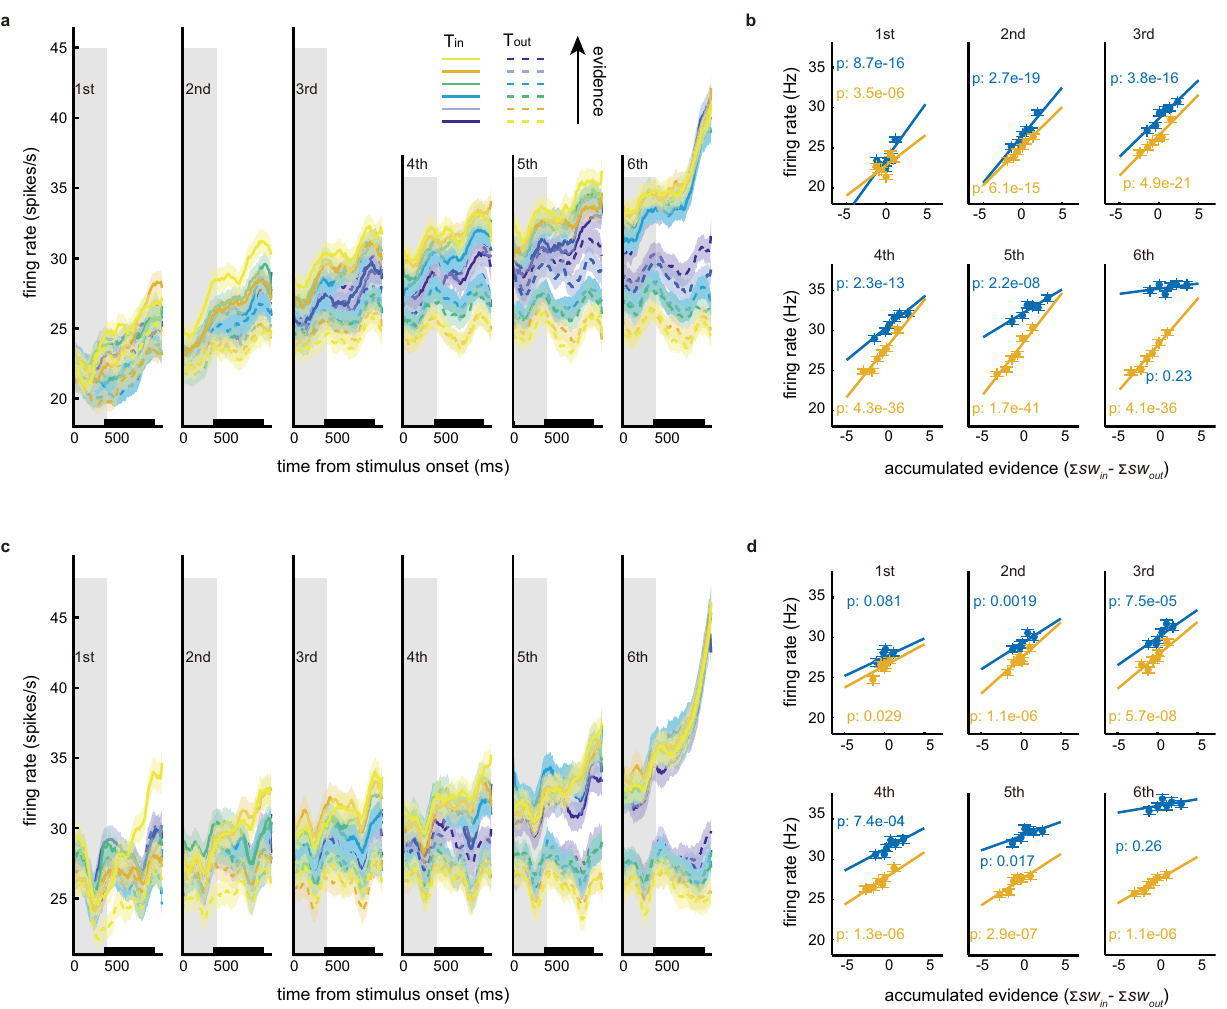
Fig. 2 | LIP responses represented accumulated evidence. a The population- averagedperi-stimulustimehistograms(PSTHs)ofthe115neuronsfrommonkeyM aligned to the stimulus onset in each epoch. The gray areas indicate the period when the stimulus is on the screen. The traces correspond to the quantiles sorted by the accumulated evidence ( ∑ SW in – ∑ SW out ) in each epoch, indicated by dif- ferent colors. Solid and dashed lines indicate the trials with T in and T out choices, respectively. Curve thickness depicts S.E. across units. b The fi ring rates (averaged